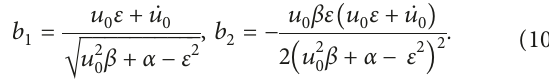
Comparison between the approximate analytical solu- tion and the numerical solution is shown in Figure 7.